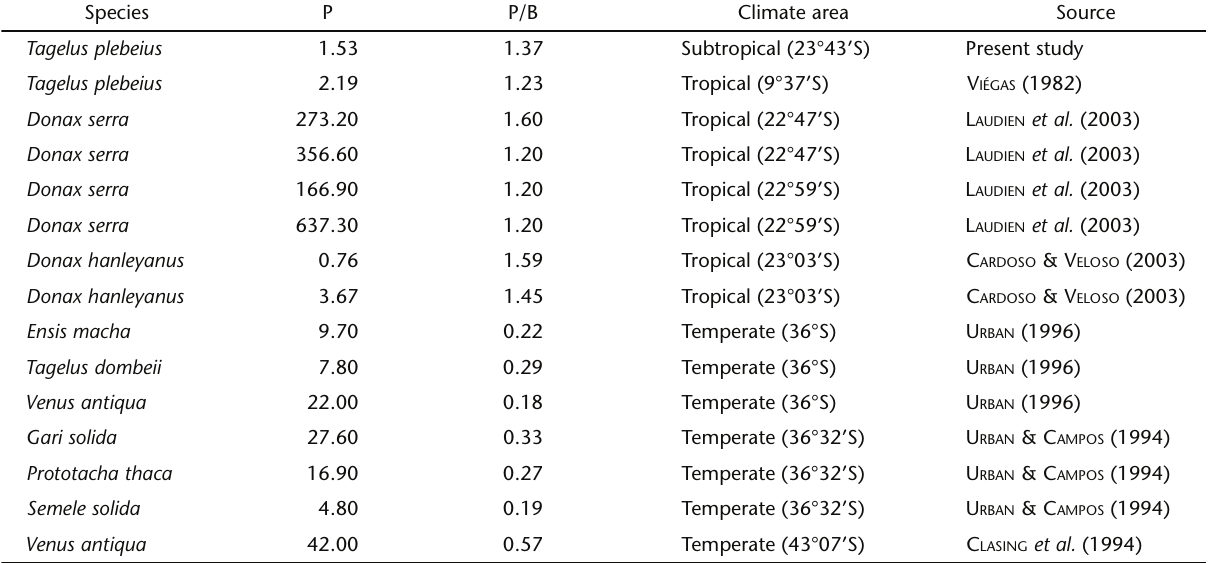
Table IV. Comparison of secondary production (P, g AFDM m -2 year -1 ) and production-to-biomass (P/) ratio of several bivalves species from different geographical regions. Species P P/B Climate area Source Tagelus